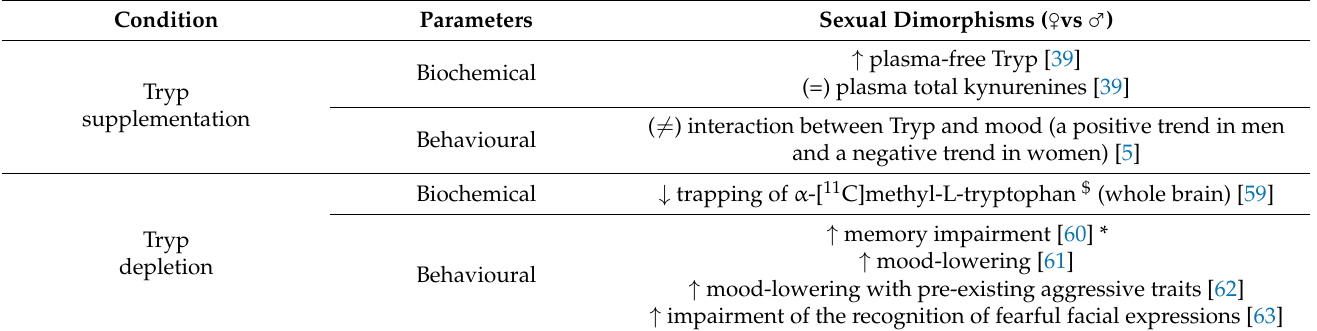
Table 2. Highlights of the impact in tryptophan nutritional status between sexes: healthy condition.